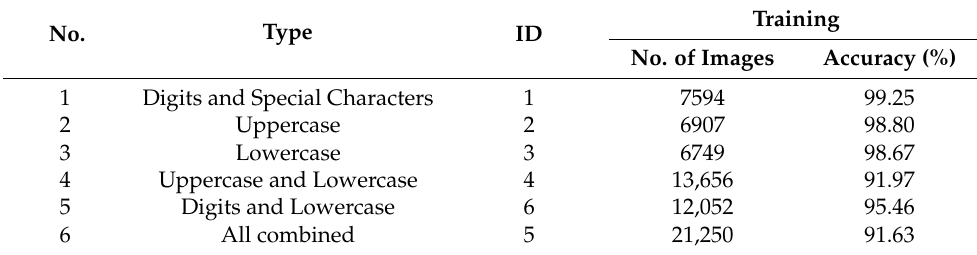
Table 2. Training accuracy for each